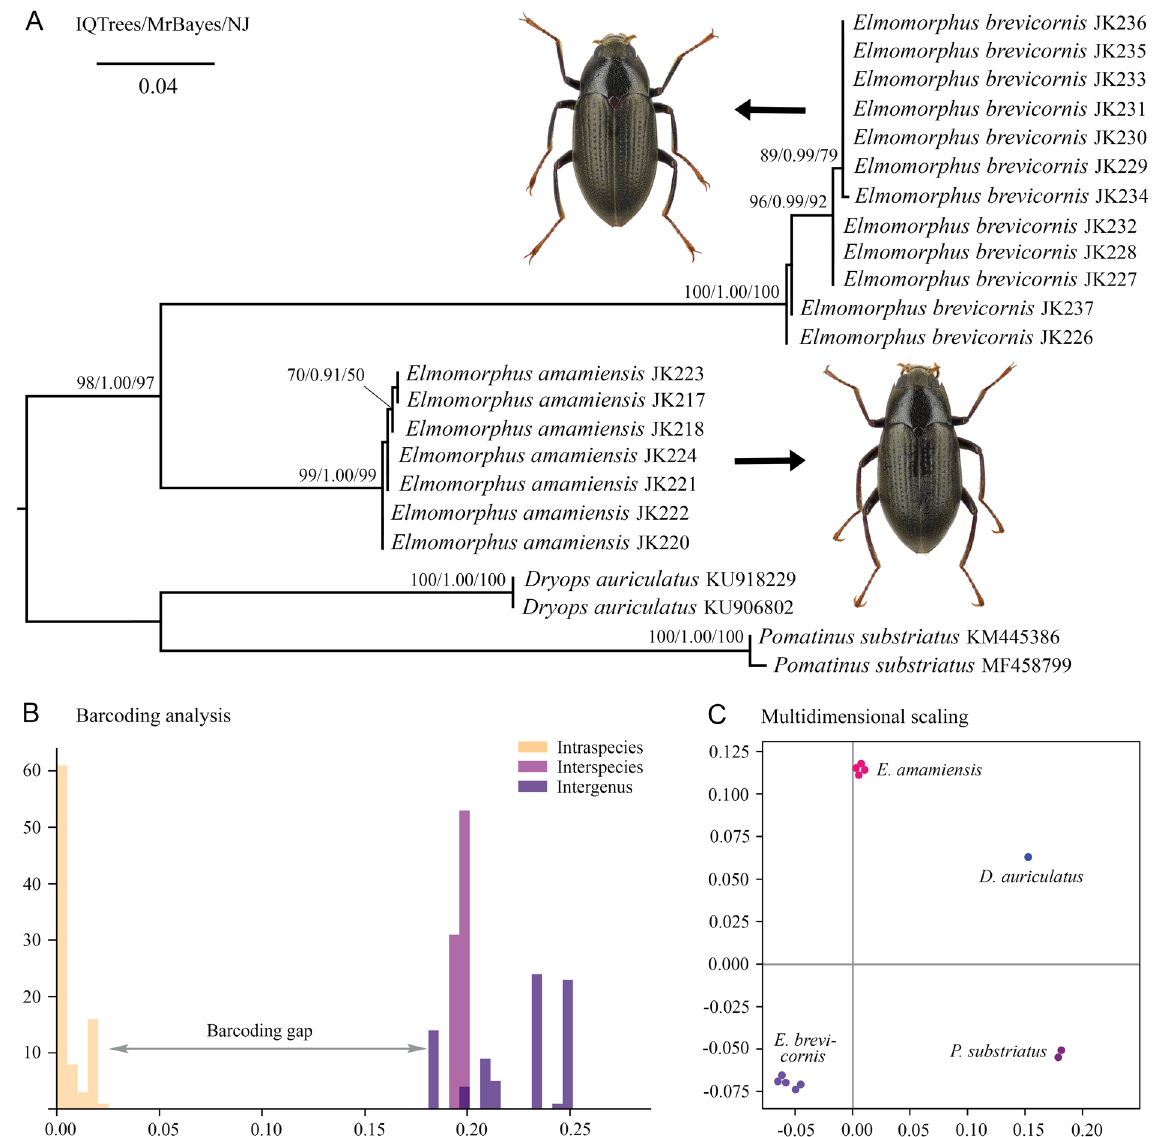
Fig. 1. Phylogenetic relationships and genetic distances between Japanese Elmomorphus species. Pomatinus substriatus (Müller, 1806) and Dryops auriculatus (Geoffroy, 1785) served as outgroup taxa in all analyses. A . Phylogenetic tree based on the mitochondrial COI gene. Bootstrap values for maximum likelihood analyses performed in IQTrees and distance NJ analyses performed in MEGA-X as well as posterior probabilities for Bayesian interference performed in MrBayes were mapped onto the best scoring IQTree. The scale bar denotes four substitutions per 100 nucleotide positions. B . Histogram displaying intraspecies, interspecies, and intrageneric distances of the taxa shown in (A). C . Multidimensional scaling based on p -distances of the taxa shown in